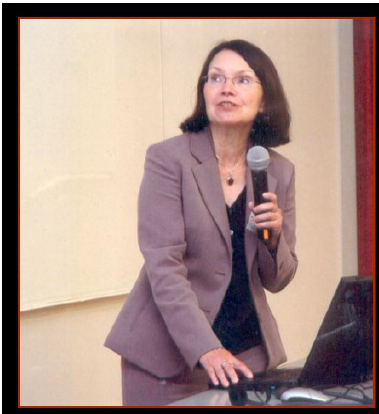
Figure 10. Barbara Płytycz (nee Malik) received her PhD degree on transplantation immunity in amphibia from the Jagiellonian University at Kraków (Kraków, Poland) in 1971. Her DSc degree (“Habilitation”) followed in 1981. In 1992, she became professor at the Zoology Institute of the Jagiellonian University. In the same year she founded the new Department of Evolutionary Immunobiology at the Zoology Institute. She can be regarded as an outstanding comparative immunologist. Her group is well known for their work on the evolution of the immune system with special attention to stress-immune interaction in mammals, amphibia, fish, and earthworms. Her picture was used with permission of the Jagiellonian University, (Kraków, Poland).